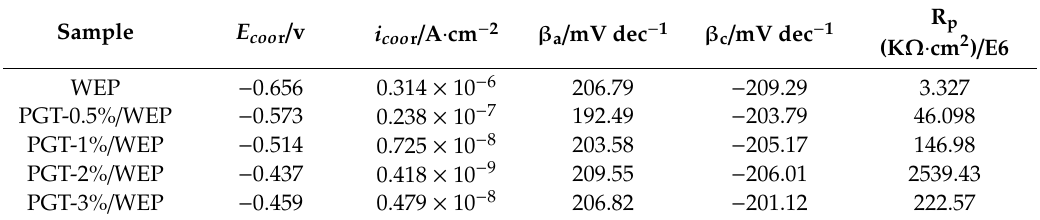
Figure 10. Polarization curves of PGT / WEP coatings immersed in 3.5 wt.% NaCl aqueous solution for 7 days. Table 1. Electrochemical corrosion study of WEP coatings with nano-PDA@GO-TiO 2 composites in 3.5% NaCl corrosive